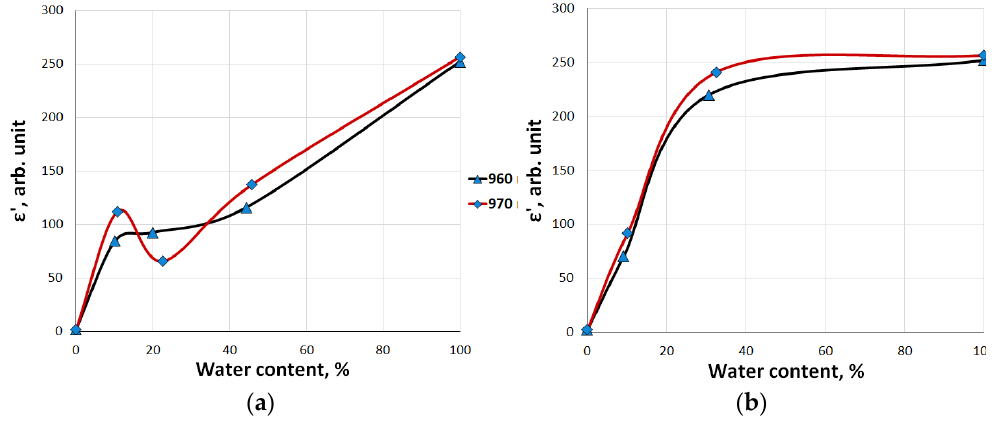
Figure 4. Dependences of the real part of CDP (at 1 MHz) on the water content for the drill cuttings from 960 and 970 m depths, saturated with water–oil mixtures: ( a ) based on oil C; ( b ) based on oil